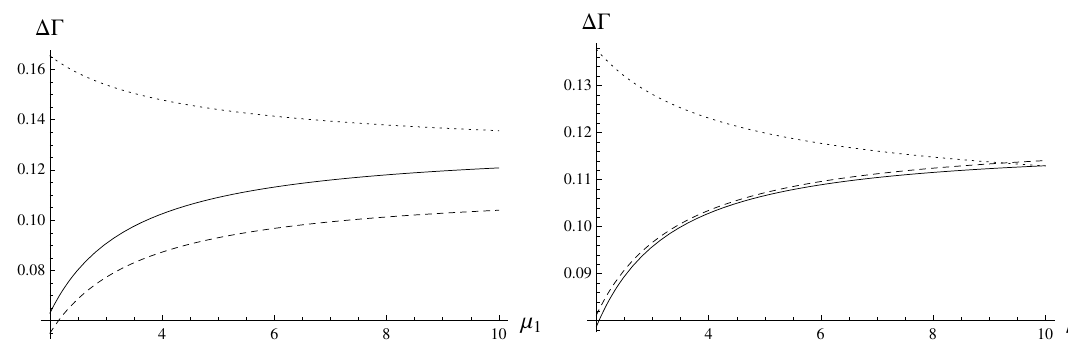
Figure 2 . Renormalization scale dependence for ∆Γ at LO (dotted), NLO (dashed), and NNLO (solid) results for the pole scheme (left) and the MS scheme (right). On the x axis is µ 1 in GeV-s. schemes, respectively. Unlike in eq. (1.9) other sources of error are neglected here. The µ 1 dependence is plotted in figure